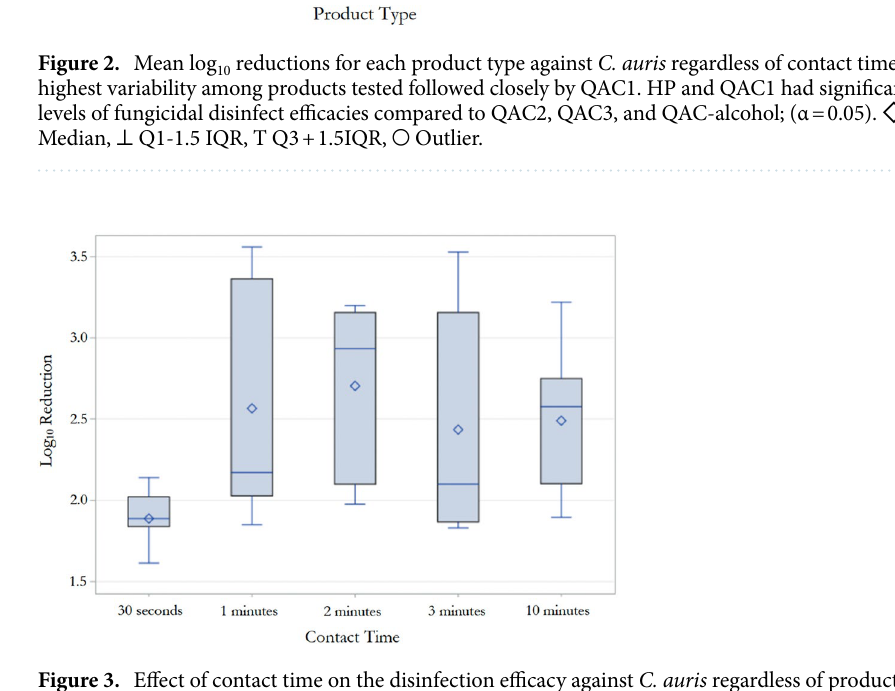
Figure 3. Effect of contact time on the disinfection efficacy against C. auris regardless of product type . 30 s of disinfection was significantly less effective than any of the other contact times i.e., one-min, two-min, three-min, and 10-min (p < 0.05). ◇ Mean, — Median, ⊥ Q1-1.5 IQR, Τ Q3 + 1.5IQR, ○